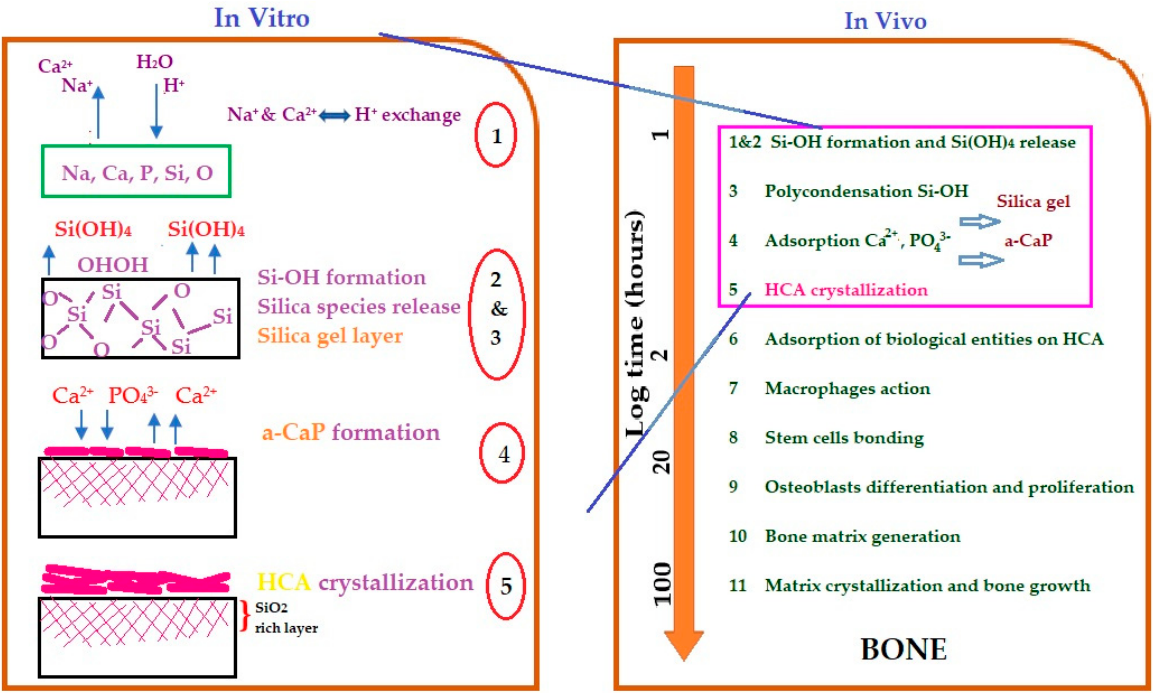
Figure 9. Bioactive mechanisms of silica glass ceramic samples using in vitro and in vivo techniques. (HCA = apatite hydroxycarbonate). Modified from Vallet-Regi [89].